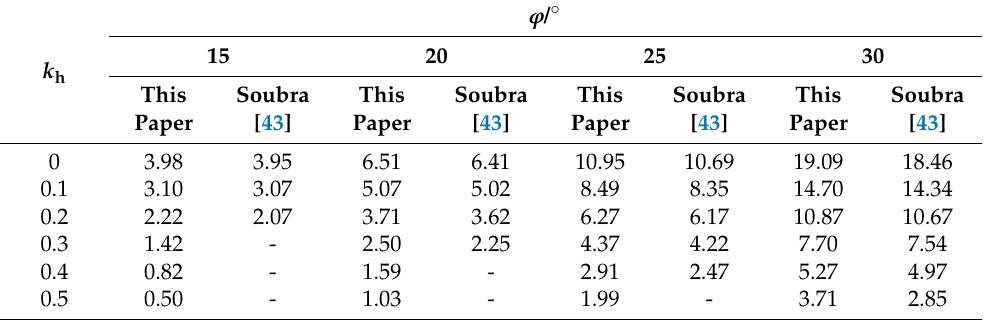
Table 5. Values of seismic bearing capacity factor N c